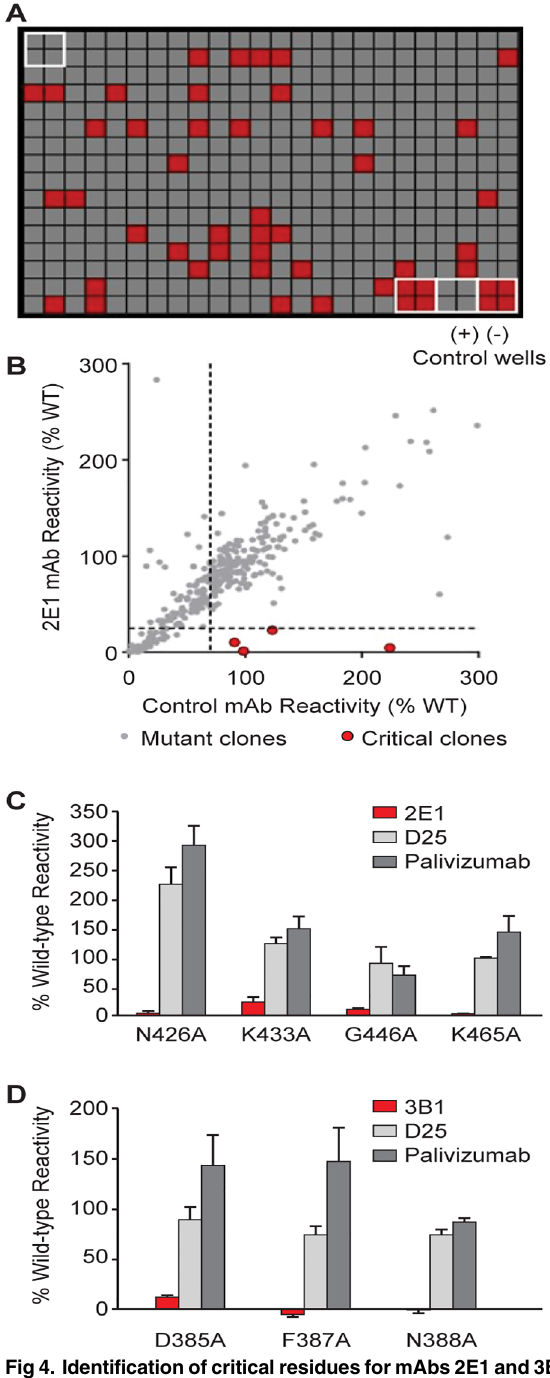
Fig 4. Identification of critical residues for mAbs 2E1 and 3B1 binding with shotgun mutagenesis epitope mapping. A shotgun mutagenesis alanine scanning library was constructed for the RSV F protein. The library contains 368 individual mutations at residues identified as surface exposed on the prefusion and postfusion forms of RSV F proteins. Each well of the mutation array plate contained one mutant with a defined substitution. (A) Reactivity results from a representative assay are shown with four positive (wildtype RSV F) and four negative (mock-transfected) control wells included on the plate. (B) Human HEK293T cells expressing the RSV F mutation library were tested for immunoreactivity with mAb 2E1, measured on an Intellicyt high-throughput flow cytometer. Clones with reactivity of < 20% relative to that of wildtype RSV F (horizontal line) yet > 70% reactivity for a control mAb (vertical line) were initially identified to be critical